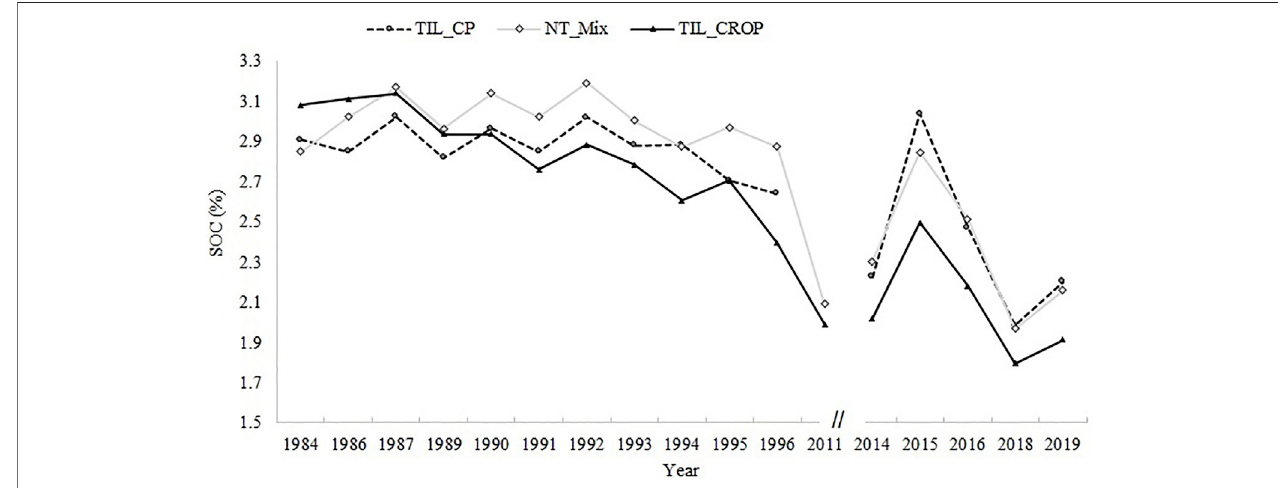
FIGURE2| Topsoilcarboncontent(SOCin%)foreachtreatmentgroup(fallowperiodbetween1997and2010wasexcluded)sincetheonsetoftheexperimentin 1984 until 2019.